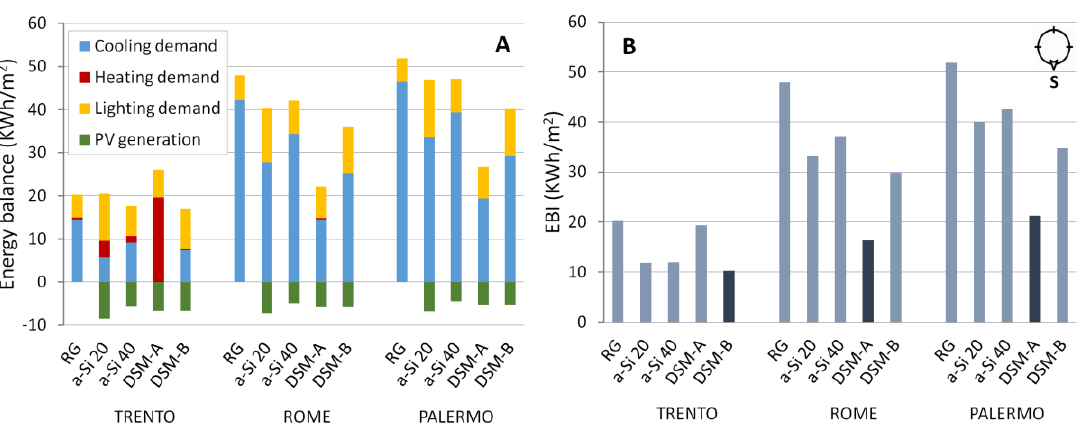
Figure 7. ( A ) Energy balance for the various STPV tested, compared to the reference glass (RG) of the STD building with northern exposure at the three locations; ( B ) Energy balance index (EBI) index evaluated for the same exposures and glazing elements.